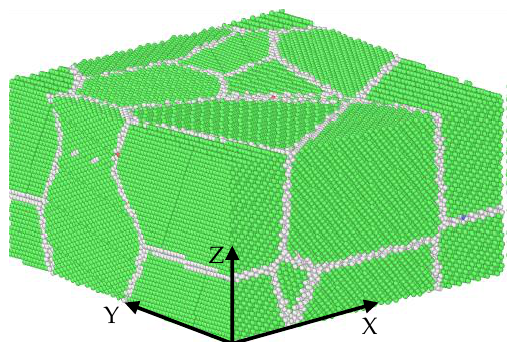
Figure 2. The simulation model.